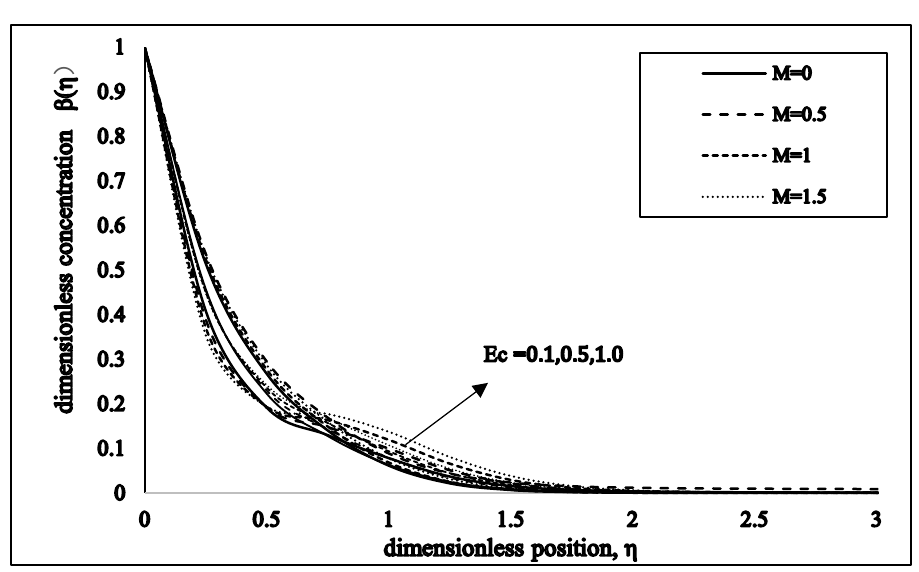
Figure 5. Impact of of 𝑀 when 𝑃𝑟 = 𝐿𝑒 = 10, 𝑁𝑏 = 0.2, 𝐸𝑐 = 0.1 and 𝑁𝑡 = 0.1 on concentration